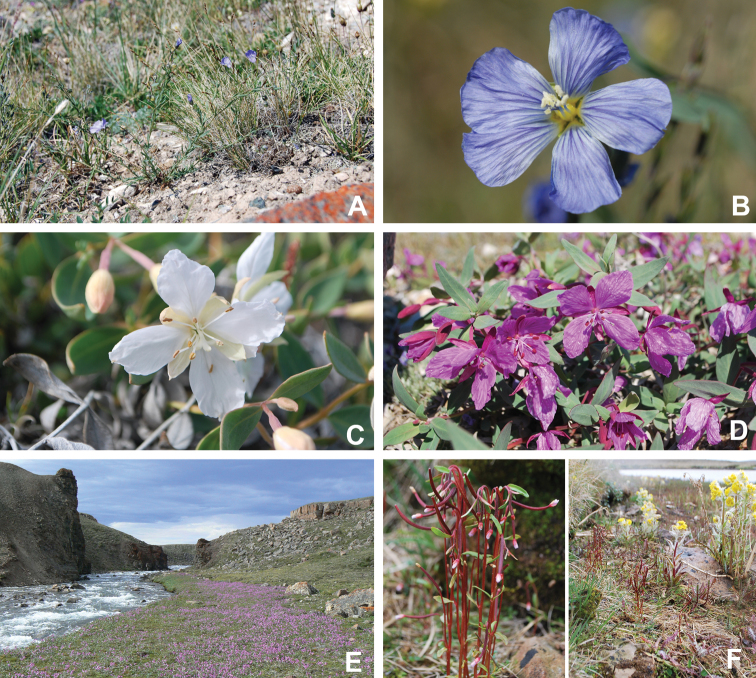
ALinum
lewisii
subsp.
lewisii habit, Gillespie et al. 9618BLinum
lewisii
subsp.
lewisii flower, Gillespie et al. 9618CChamaenerion
latifolium inflorescence (white-flowered form), Minto Inlet, NT, 21 July 2010 DChamaenerion
latifolium habit, Minto Inlet, NT, 21 July 2010 EChamaenerion
latifolium habitat, Minto Inlet, NT, 21 July 2010 FEpilobium
arcticum habit (left) and habitat (right). Photos A, B by J.M. Saarela C, D, F by B.A. Bennett and E by P.C. Sokoloff.